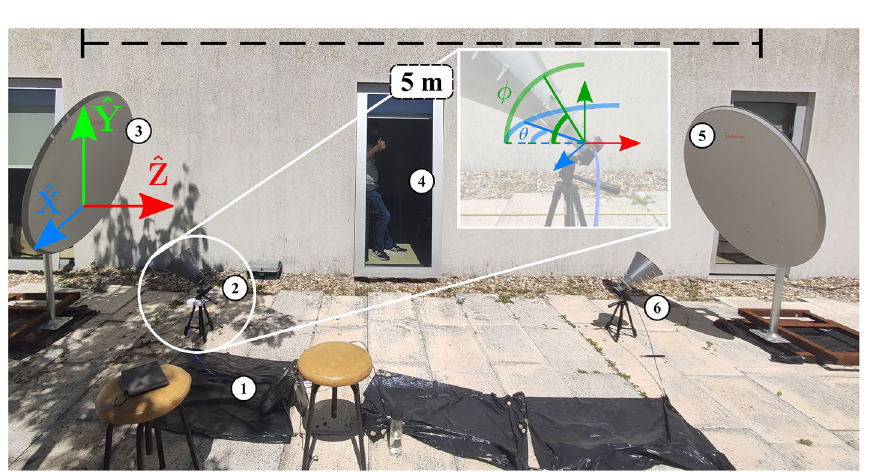
Figure 4. Complete 5 m double-reflector system overview with position axis and attitude angles yaw, θ , and pitch, φ . The components are: (1) Microwave generator and receiver; (2) Transmitting horn antenna; (3) First parabolic reflector; (4) Beam focus location; (5) Second parabolic reflector; (6) Receiving horn